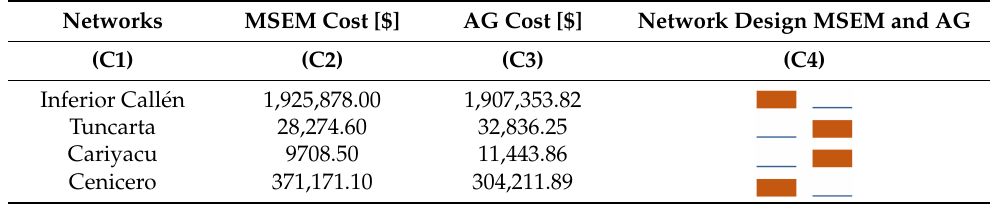
Table 7. Cost difference between SEM and AG network